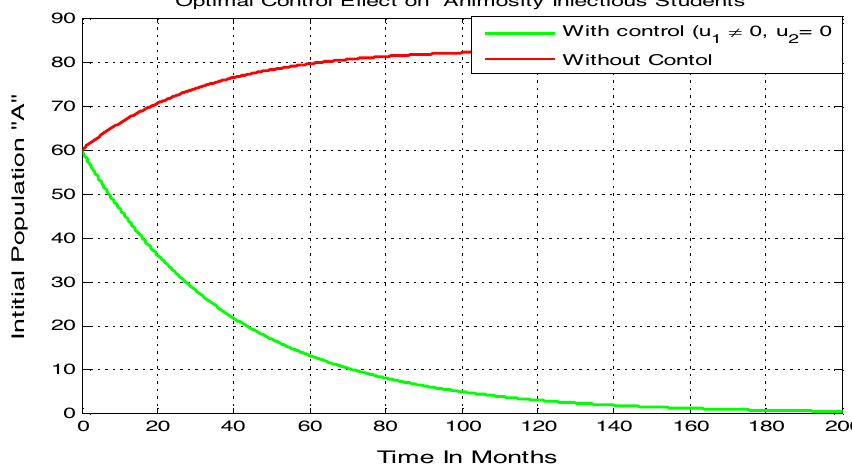
Figure 9. Variation in animosity infected students with prevention ( u 1 = 0 , u 2 = 0 ) control